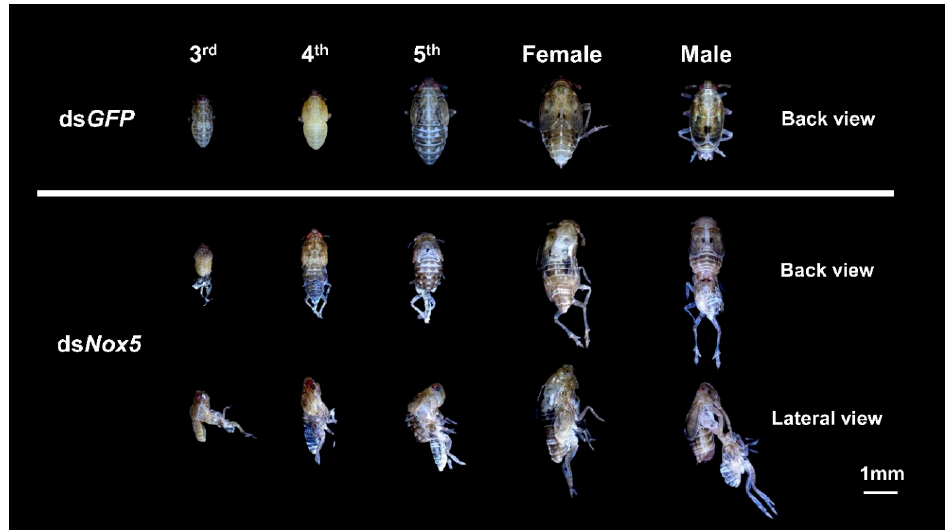
Figure 3. RNA interference (RNAi) analysis of Nox5 effects on N. lugens development. The newly hatched 2nd-, 3rd-, 4th- or 5th-instar nymphs were injected with ds Nox5 . The 2nd–5th instar nymphs treated with ds GFP were used as controls, individually. The lethal phenotypes are shown in ds Nox5 -injected individuals in the 3rd-, 4th-, 5th-instar nymph and the adult stages. RNAi led to a significant reduction in the survival rates of the insects. The survival rates of ds Nox5 -treated 2nd-instar nymphs were 84% at 3 d.p.i. (days post injection) and gradually decreased to 49% at 15 d.p.i (Figure 4A). The survival rates of ds Nox5 -treated 3rd- and 4th-instar nymphs were 88%–92% at 3 d.p.i. and decreased to 46%–49% at 15 d.p.i. The survival rates of ds Nox5 -treated 5th- instar nymphs were 84% at 3 d.p.i. and quickly declined to 33% at 15 d.p.i. By contrast, the survival rates of non- and ds GFP -treated 2nd-, 3rd- or 4th-instar nymphs were more than 85% and the 5th- instar nymphs were more than 75% at 15 d.p.i. Quantitative real-time PCR confirmed that the transcript levels of Nox5 in each developmental stage (2nd–5th nymphs) were notably reduced in RNAi-treated nymphs compared with non- and ds GFP -treated controls (Figure 4B).